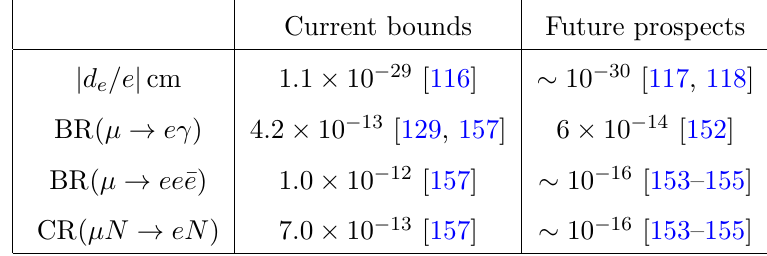
Table 2 . Current experimental bounds and future prospects of relevant